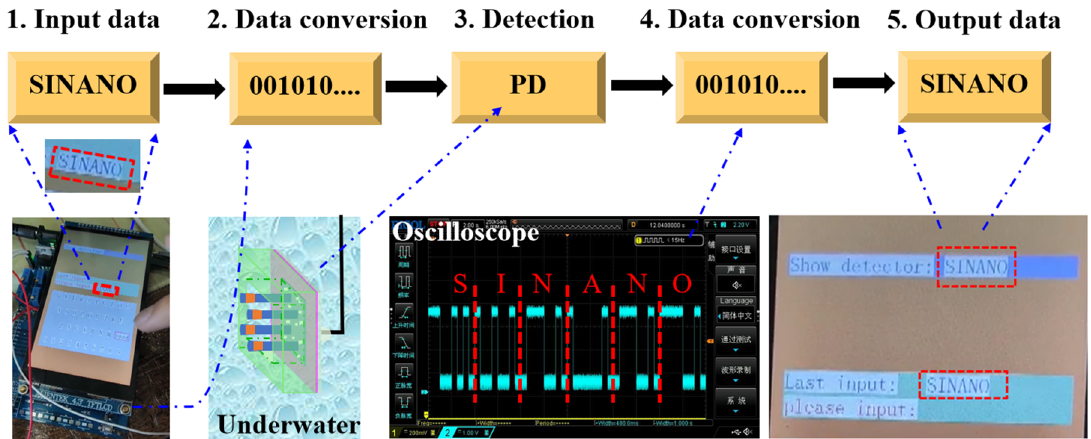
Figure 7. Proof of the underwater communication system based on the self-powered PEC PD. The system contains the display interface and the control panel with an electrical circuit for inputting and converting signals by ASCII codes.